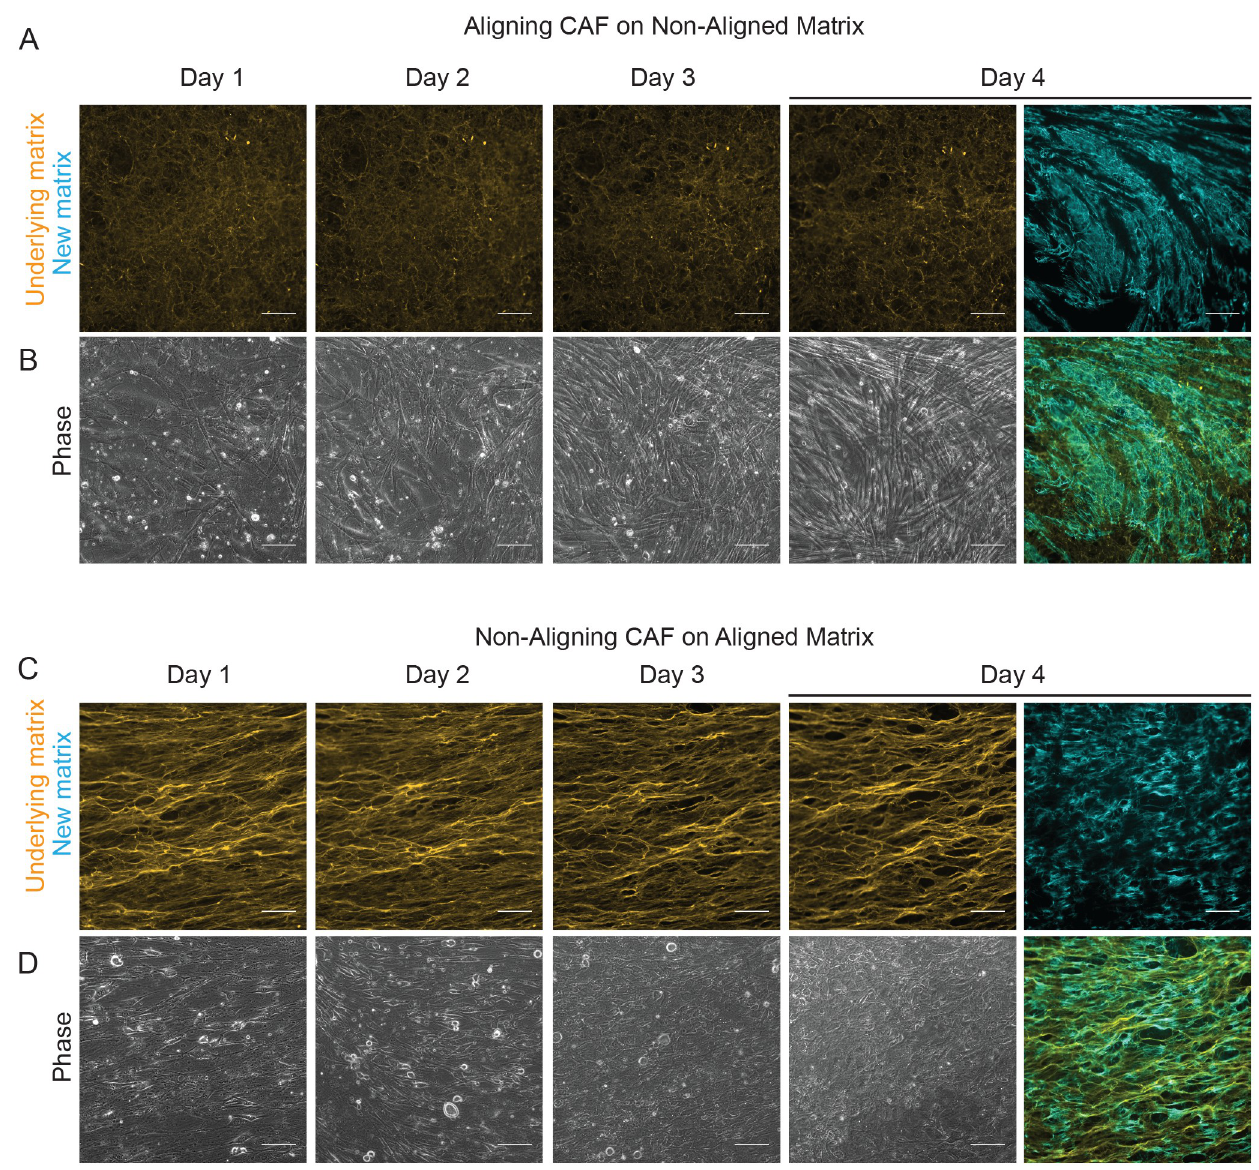
Fig 7. Modelling conversion between matrix patterning in vitro . (A) Non-aligning fibroblasts were seeded onto a pre-existing anisotropic matrix. The pre- existing matrix is shown in yellow, new matrix produced over the duration of the assay is shown in blue and the composite image after four days is shown on the right. (B) Corresponding zoomed-in phase imaging of cell-body organization. For the first two days cells follow the matrix and align, but this order breaks down by day 3. (C) Aligning fibroblasts were seeded onto a pre-existing isotropic matrix. (D) Corresponding zoomed-in phase image of cell-body organization. On day 1 cell body orientation is disorganized and follows the isotropic matrix. By day 3 fibroblasts start to ignore the matrix and align. Scale bars represent 100 μm